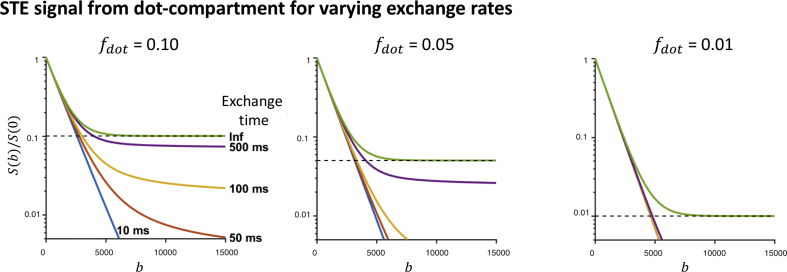
Simulated signal at variable fdot and effective exchange times assuming a two compartment Kärger-model. Here, the diffusivities of the two compartments were set to 1 and 0 μm2/ms.